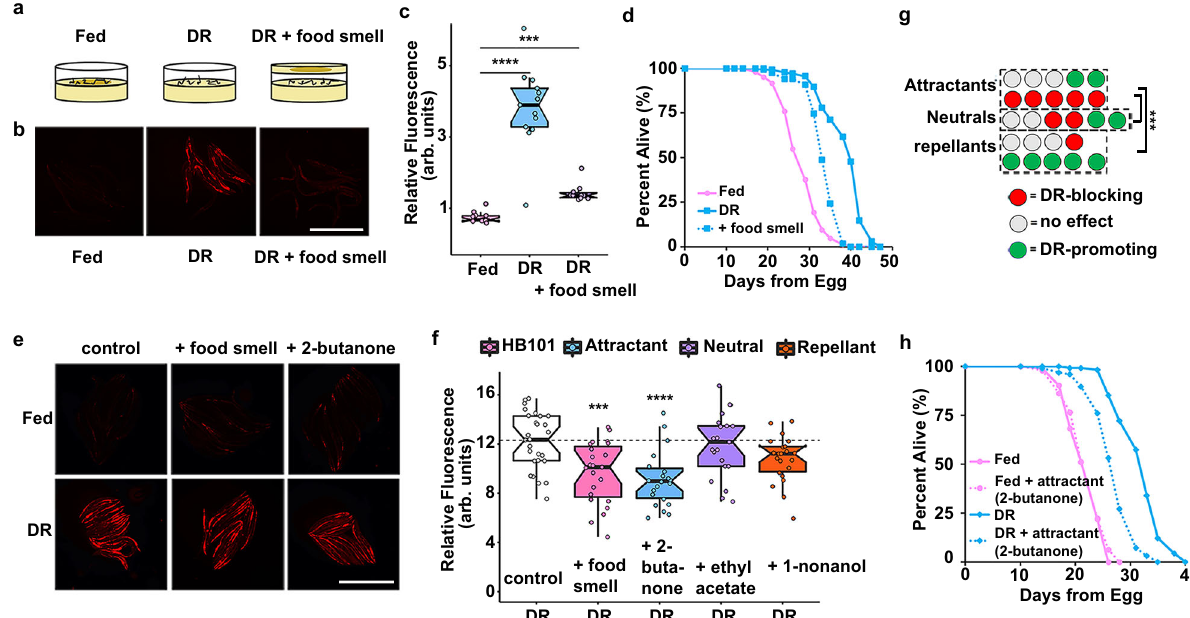
Fig. 1 Attractive food smell blocks dietary restriction-mediated fmo-2 induction and longevity. Diagram of “ smell plates ” ( a ). Images ( b ) and quanti fi cation ( c ) of individual fmo-2p :: mCherry worms on fed (pink), DR (blue) and DR + food smell (OP50) (purple). Scale bar, 1 mm. n = 12 (fed), 13 (DR), 10 (DR + food smell) biologically independent animals. p -value = 2.95e-09 (DR vs. fed), 2.14e-06 (DR + food smell vs. fed). Survival curves ( d ) of N2 (WT) animals fed (pink) or DR (blue) under normal conditions (solid lines) or subjected to the smell of bacteria (dotted line). Images ( e ) and quanti fi cation ( f ) of individual fmo-2p :: mCherry worms on DR plates exposed to food smell (HB101) (pink) or attractive (2-butanone in blue), neutral (ethyl acetate in purple), or repellant (1-nonanol in orange) odorants. Scale bar, 1 mm. n = 28 (DR), 23 (DR + food smell), 22 (DR + 2-butanone), 25 (DR + ethyl acetate), 22 (DR + 1-nonanol) biologically independent animals. p -value = 0.000374 (DR vs. DR + food smell), 1.12e-05 (DR vs. DR + 2-butanone), 0.442 (DR vs. DR + ethyl acetate), 0.9993 (DR vs. DR + 1-nonanone). g Summary of the effects of 26 odorants on fmo-2 induction during DR. Survival curves ( h ) of N2 (WT) animals fed (pink) or DR (blue) under normal conditions (solid lines) or subjected to attractive odorants (dotted line). *** P < .001, **** P < .0001 when compared to fed (Welch Two Sample t-test, two-sided). The box plots display the median by the middle line of the box. The upper boundary of the box indicates the 75% interquartile range, and the lower boundary indicates the 25% interquartile